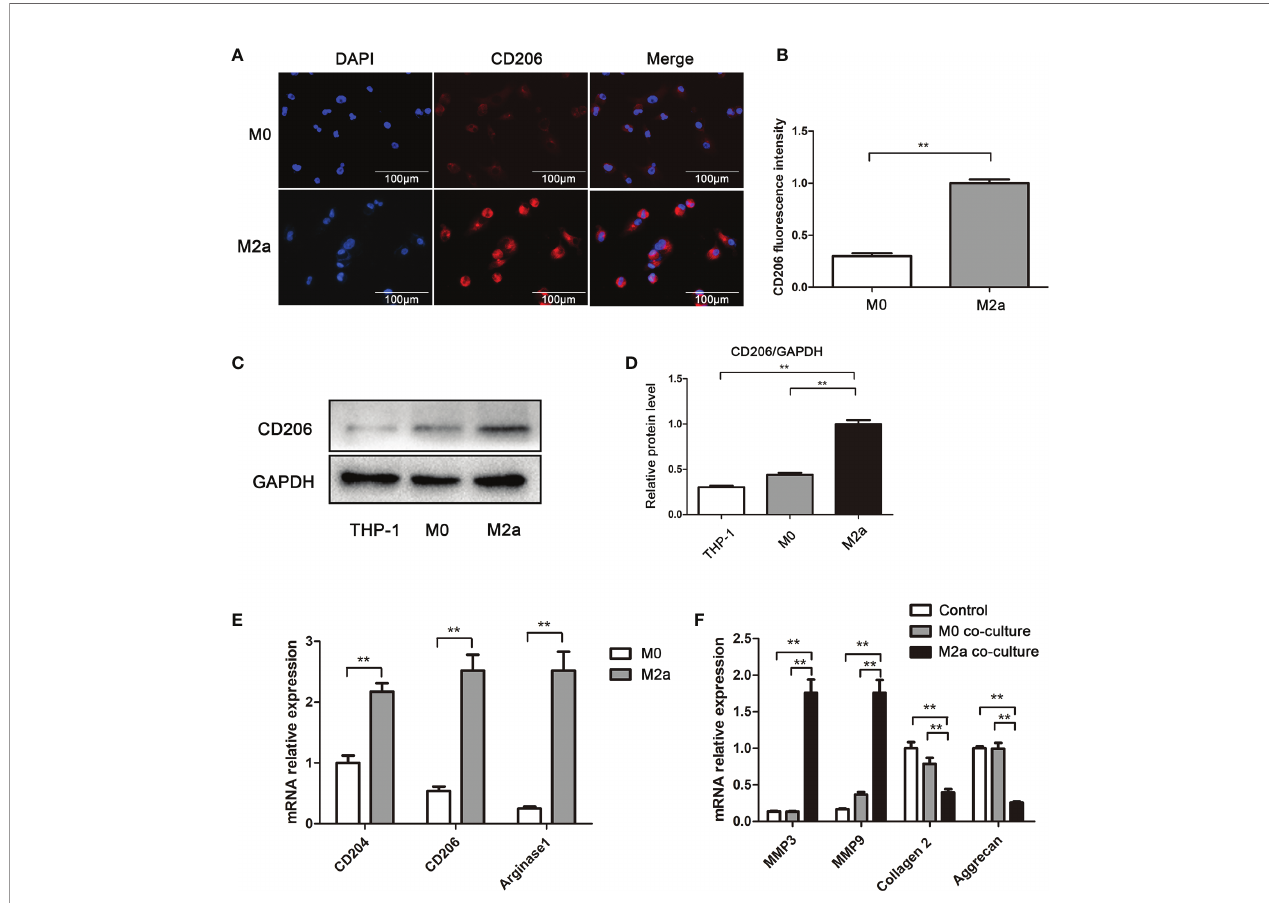
FIGURE 2 | M2a macrophages promoted ECM degradation in NP cells. (A) Immuno fl uorescence analysis of the CD206 differentiation marker in M2a macrophages. M0 and M2a macrophages were differentiated from THP-1 monocytes by stimulation with phorbol 12-myristate 13-acetate or IL-4, respectively. Immuno fl uorescence staining for CD206 was performed. Scalebar, 100 µm. (B) Semi-quantitative analysis of CD206 immuno fl uorescence staining results. (C) Western blotting analysis of CD206 differentiation marker in M2a macrophages. M0 and M2a macrophages were differentiated from THP-1 monocytes. The protein levels of CD206 in THP-1, M0 (i.e., control), and M2a macrophages were determined by western blotting. (D) Quanti fi cation of CD206 protein levels in western blots. (E) qRT-PCR analysis of M2a macrophage differentiation marker genes (CD204, CD206, and arginase-1). (F) Effects of M2a macrophages on NP cells via Transwell co-culture. M0 and M2a macrophages were differentiated from THP-1 monocytes, then co-cultured with NP cells for 48 h. MMP3, MMP9, collagen II, and aggrecan expression levels of NP cells were analyzed by qRT-PCR. Experiments were repeated three times in triplicate. The dates were analyzed by One-way analysis of variance (ANOVA). Statistically signi fi cant difference: **P<